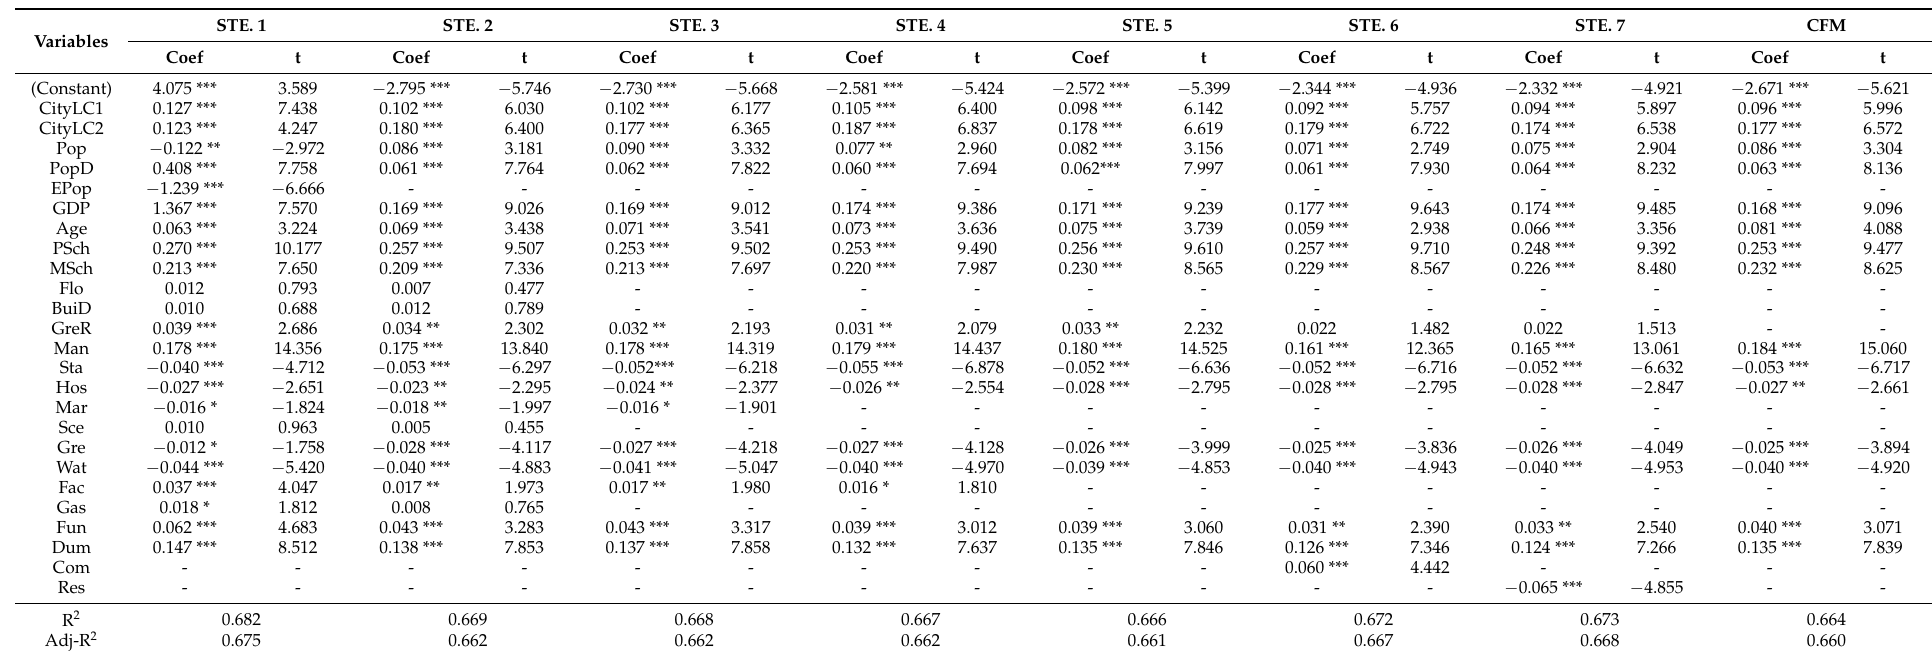
Table 2. Regression processes of filtering model variables (N =